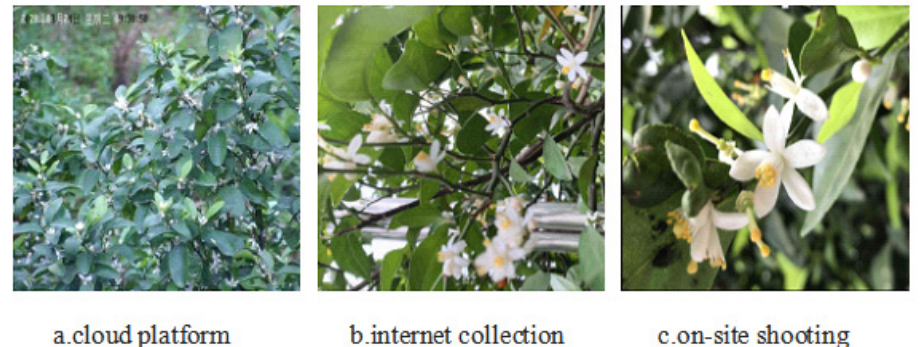
Figure 1. Images obtained in different